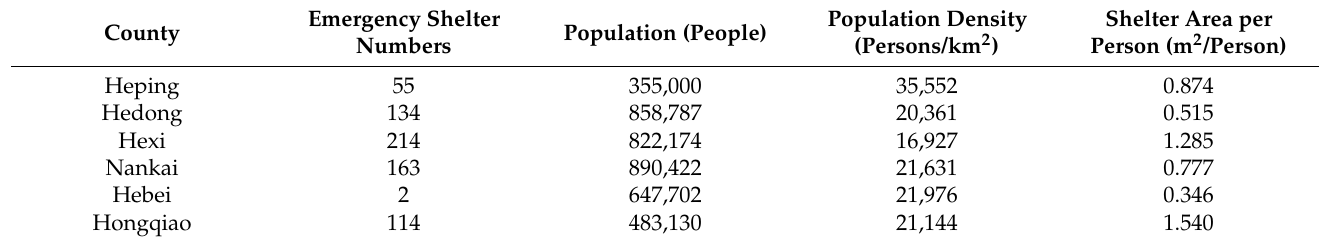
Table 1. The basic data for emergency shelters and population in the Tianjin urban